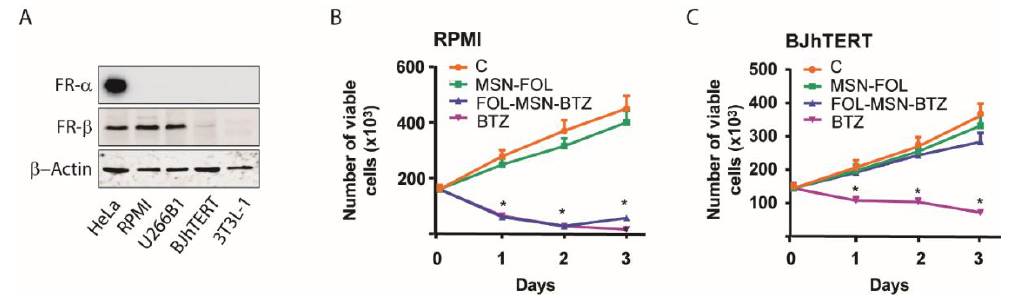
Figure 1. FOL-MSN-BTZ kills FR + MM cells but not normal cells. ( A ) 50 µ g of non-denatured proteins (for FR- α detection) and denatured proteins (for FR- β detection) from total lysates of indicated cell lines were loaded and subjected to WB analysis. β -actin was used as loading control. FOL-MSN-BTZ induces death in FR + RPMI-8226 (RPMI) MM cells ( B ) but not in FR- BJhTERT normal cells ( C ). Cells were treated for 1h with FOL-MSN-BTZ or left untreated (C = control). MSN-FOL was used as negative control and the free drug BTZ as positive control. (*) p < 0.05 vs.